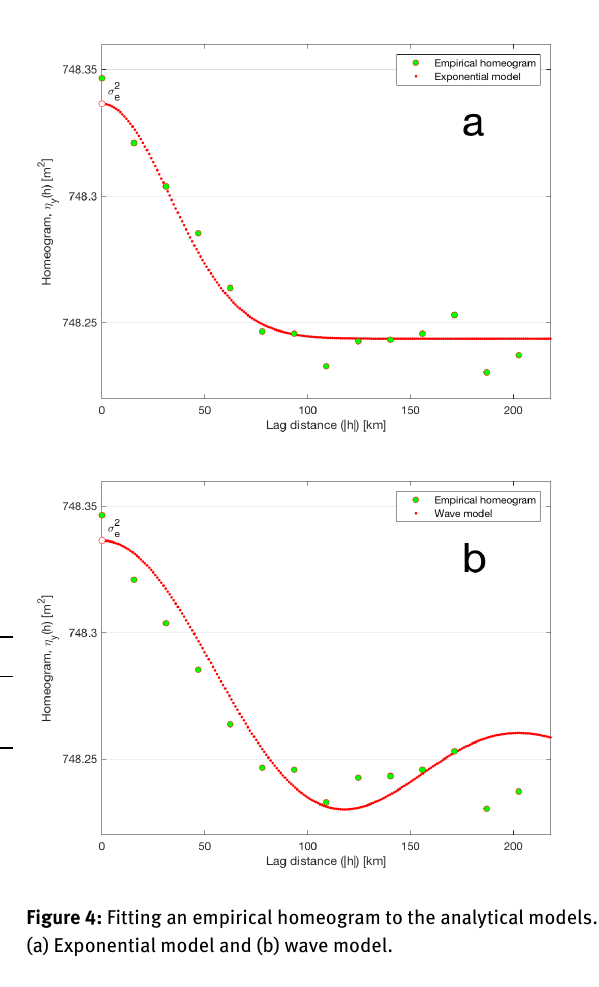
Figure 4: Fitting an empirical homeogram to the analytical